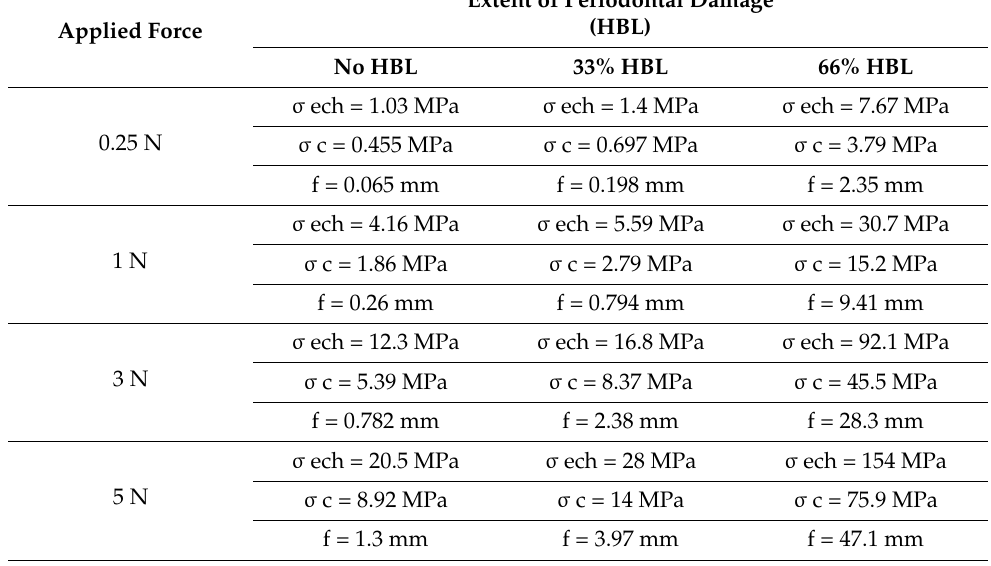
Table 4. Simulation of lingualization in the